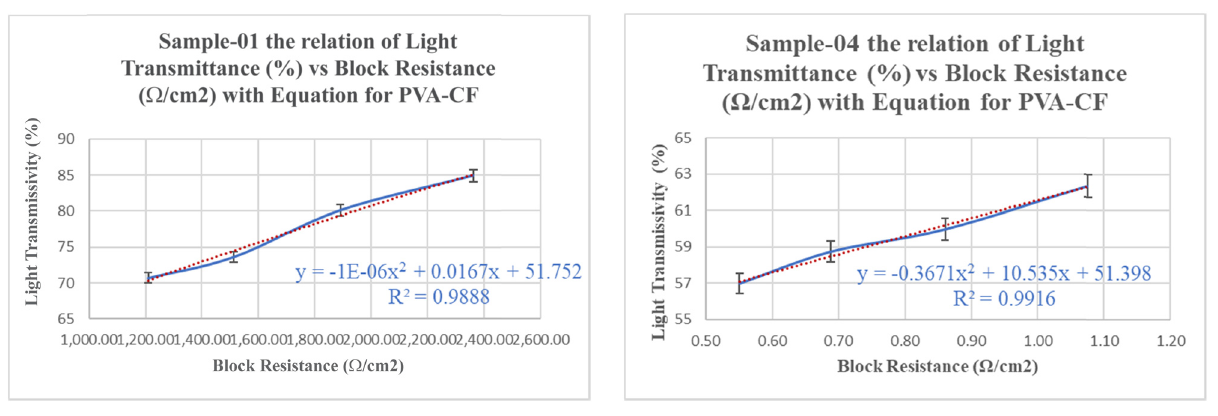
Figure 24: Sample - 04 ( CF:PVA = 0.6:30 ) light transmittance ( % ) versus block resistance ( Ω ) with equation for PVA - CF. The dotted lines repre - sent the polynomial fi tted curve and the linear fi tted